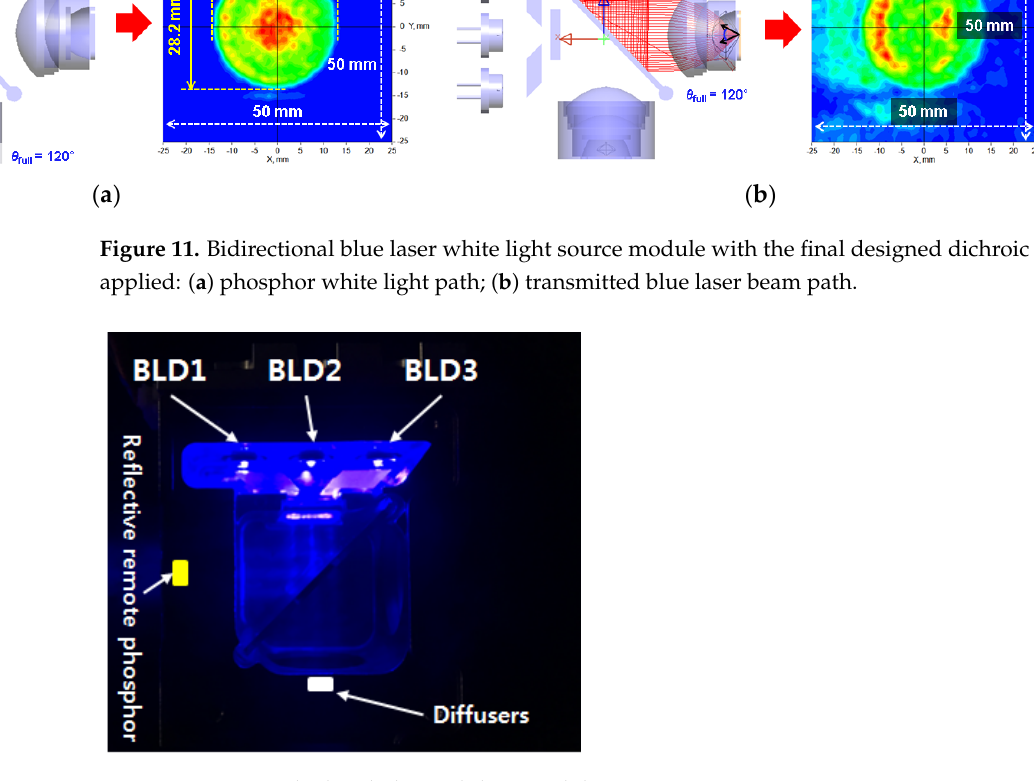
Figure 12. Proposed white light module optical design.